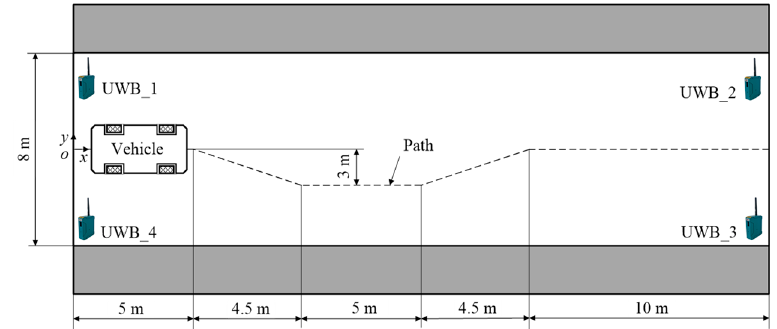
Energies 2022 , 15 , x FOR PEER REVIEW Figure 7. Site of double lane shifting driving path. Figure 7. Site of double lane shifting driving path.